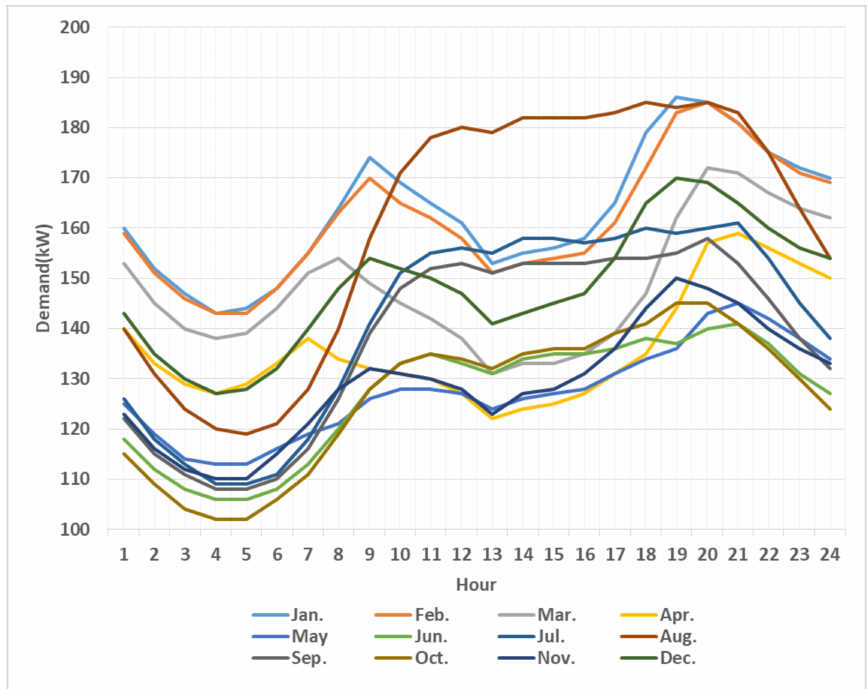
Figure 1. Daily load pattern.